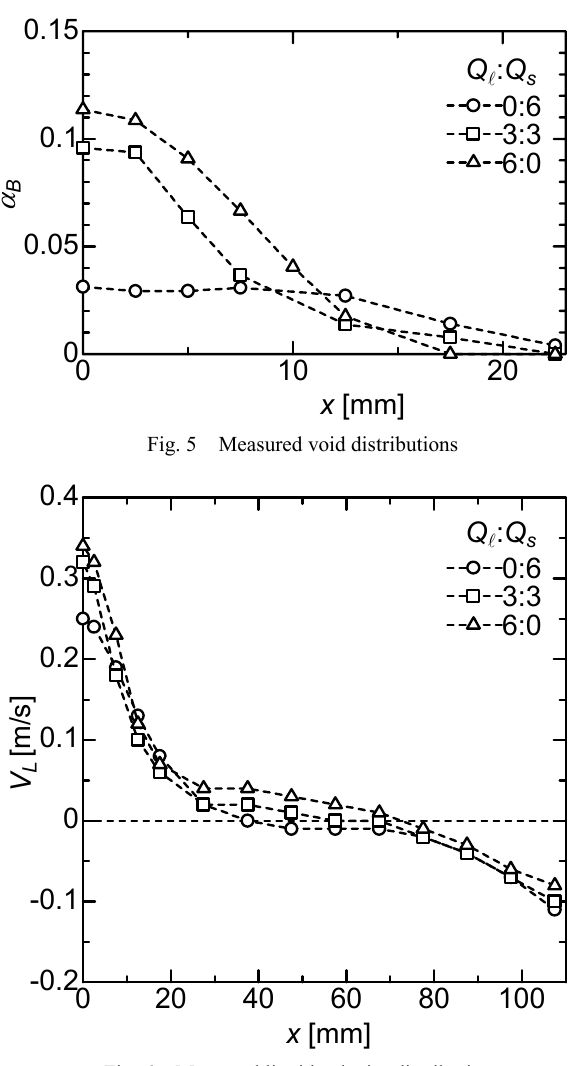
Fig. 6 Measured liquid velocity